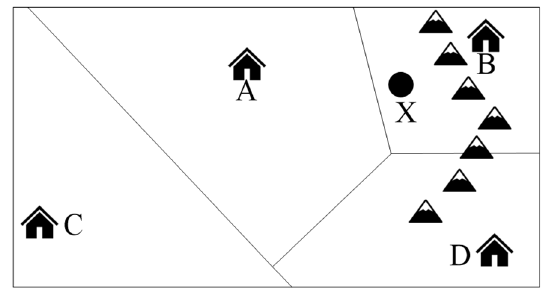
Figure 9. Limitations of Voronoi diagram with regard to geographical barriers.